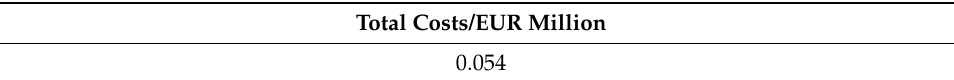
Table 17. Resulting costs of the dynamic curtailment variant.